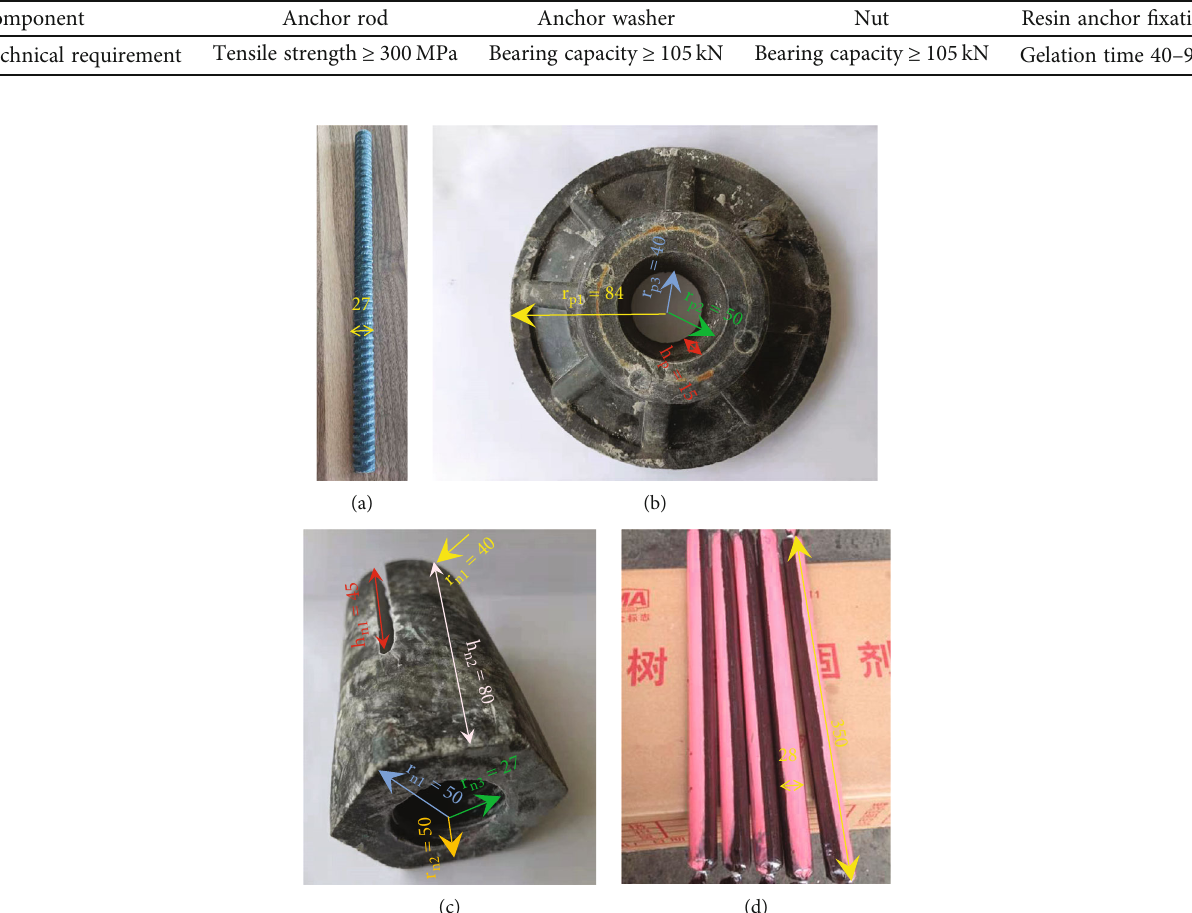
Table 1: Test materials and technical speci fi cations (provided by the manufacturer).